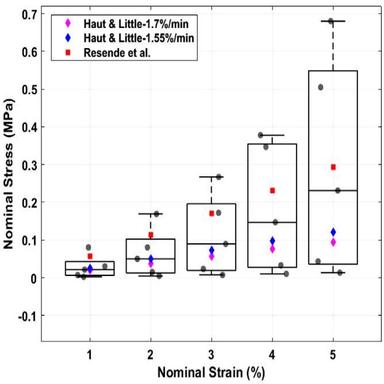
The box plot shows nominal stress and strain calculated from the Ogden material model parameters for the current study. The scattered dots in magenta, blue and red are nominal stress and strain values obtained from previous literature. Although sample deviations appear to be large, the median nominal stresses (the line in the middle of the boxes) agree with the values in the literature. (For interpretation of the references to color in this figure legend, the reader is referred to the web version of this ar